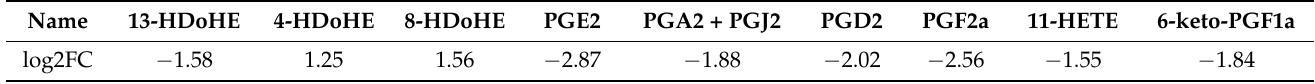
Table 1. Log2 FCs (fold changes) are shown for nine metabolites, p < 0.05 (adjusted for multiple testing).